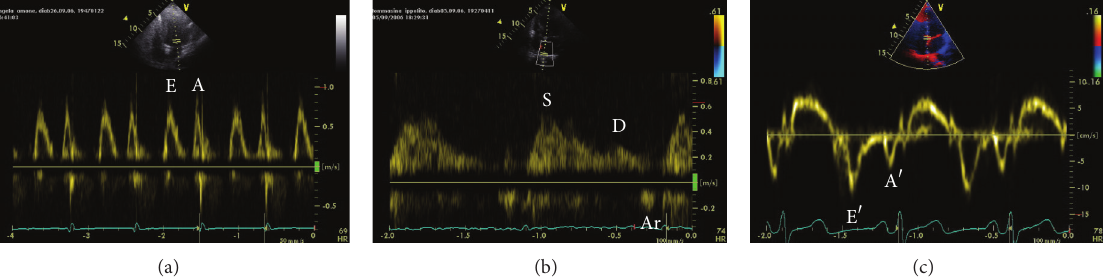
Figure 4: Atrial contraction: wave (a) at mitral inflow (a), peak retrograde diastolic (Ar) velocity at pulmonary venous flow (b) by pulsed Doppler, and late diastolic (A 󸀠 ) velocity by pulsed wave tissue imaging (c).